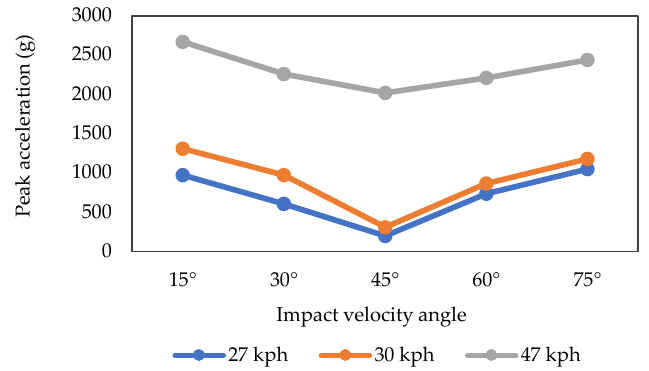
Figure 15. Simulation results of peak acceleration in case II.